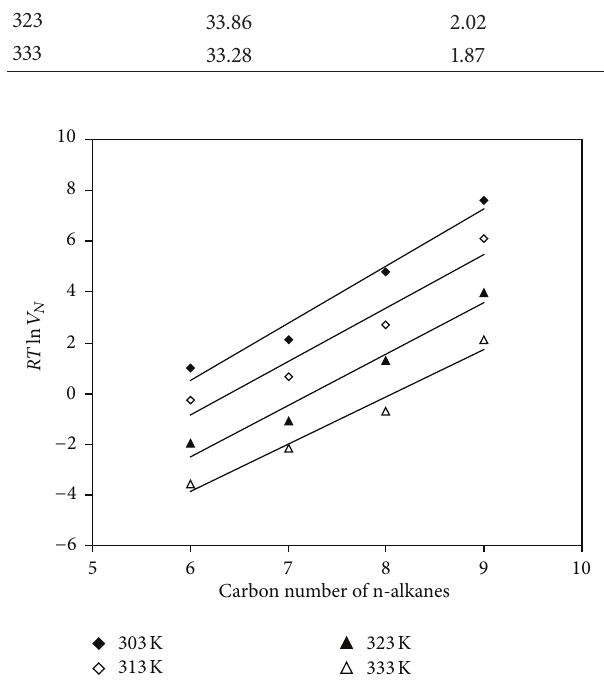
Figure 4: The plot of 𝑅𝑇 ln 𝑉 𝑁 versus carbon number of n -alkanes.